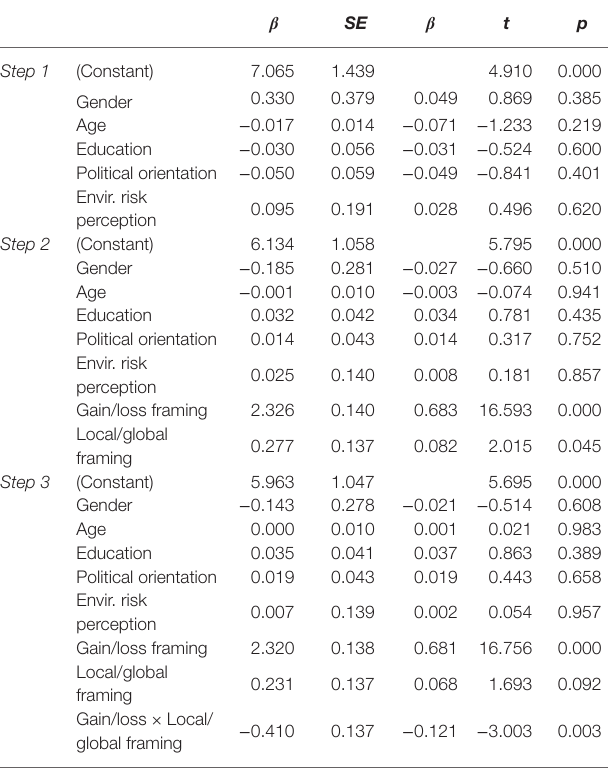
TABLE 3 | Predictors of participants’ agreement with the statement on the economic impact of the policy (Study